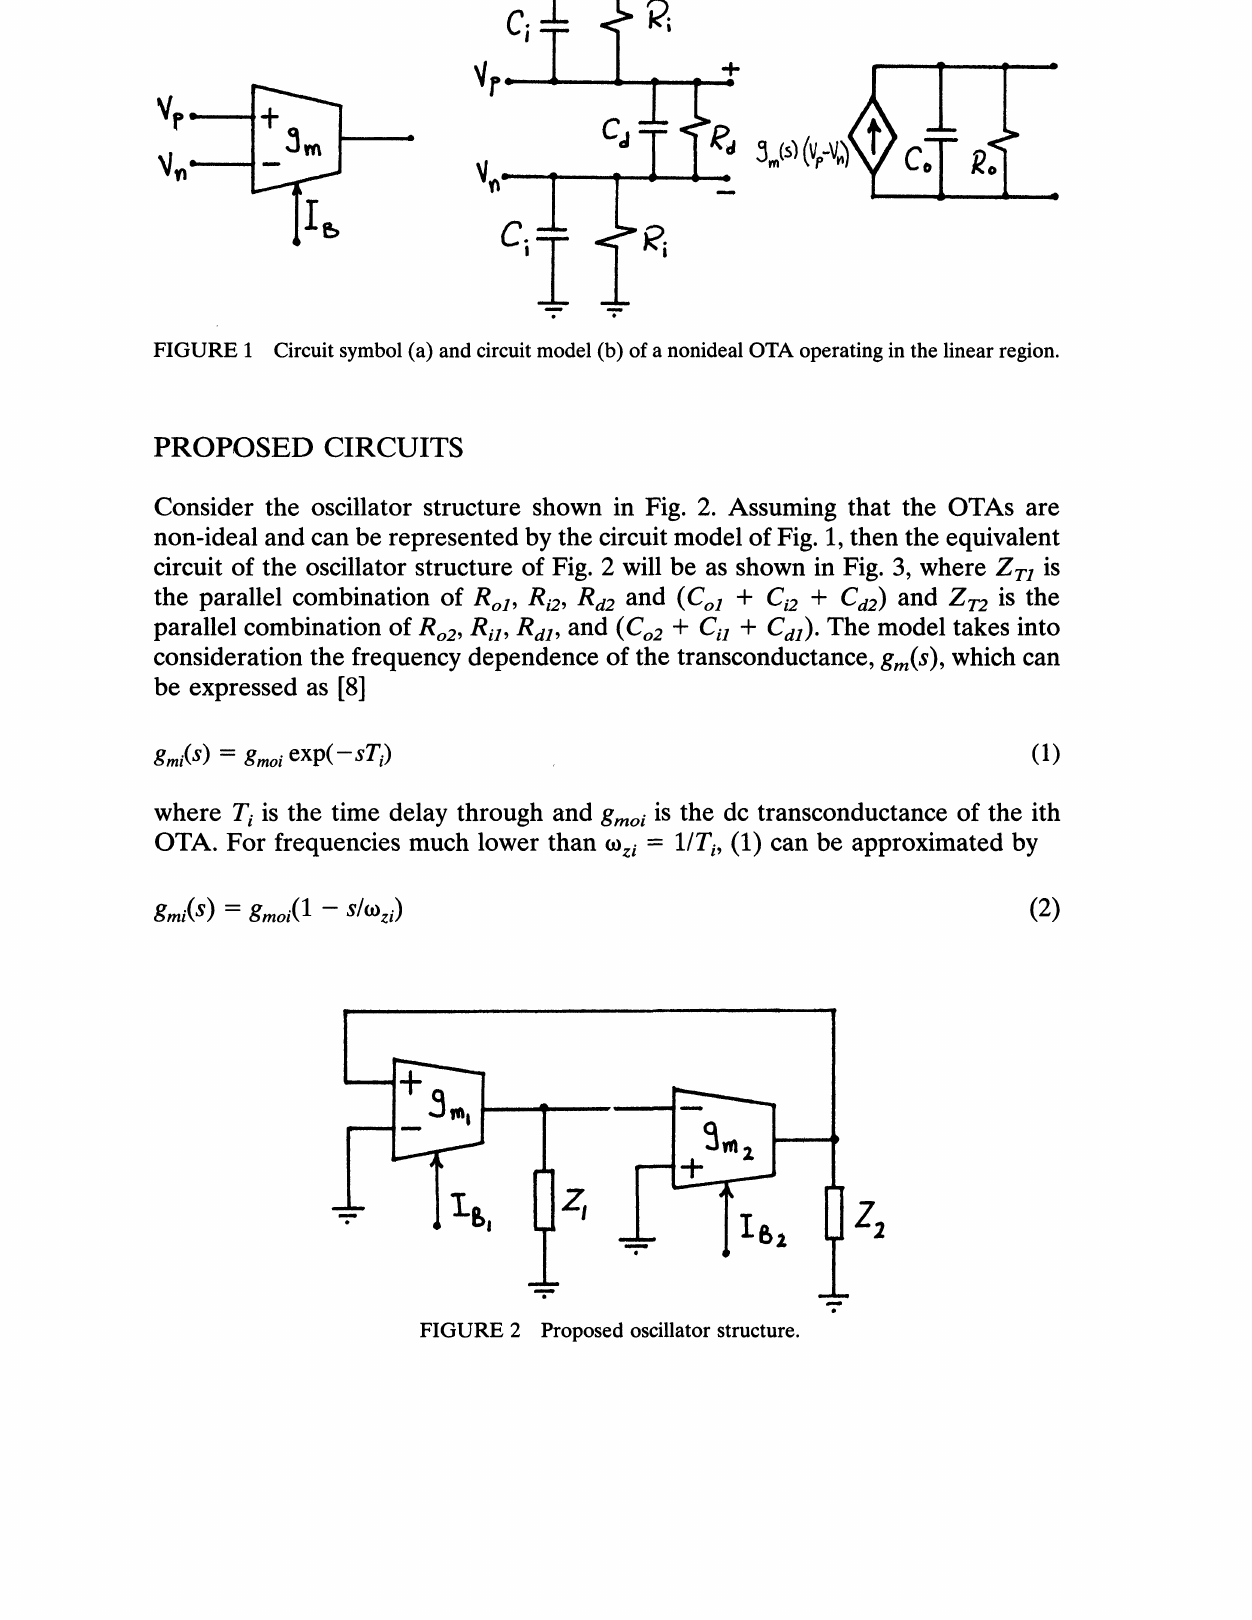
FIGURE 2 Proposed oscillator